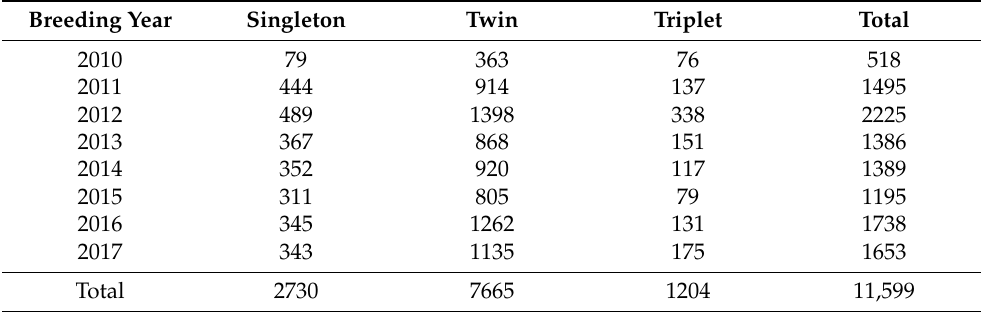
Table 1. Number of maternal composite ewe lambs bred by maternal birth type and breeding year. Breeding Year Singleton